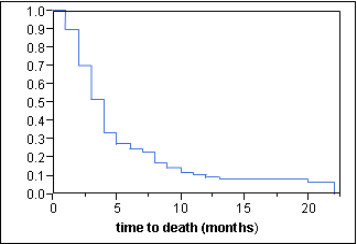
Overall survival of the entire cohort (Kaplan-Meier curve).